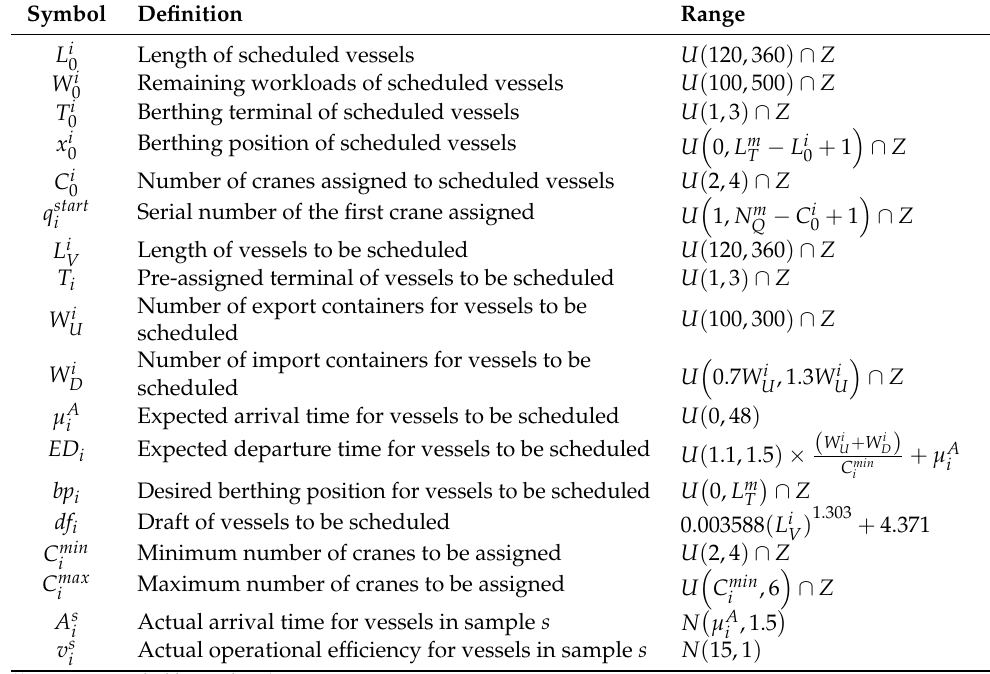
Table 5. Vessels data